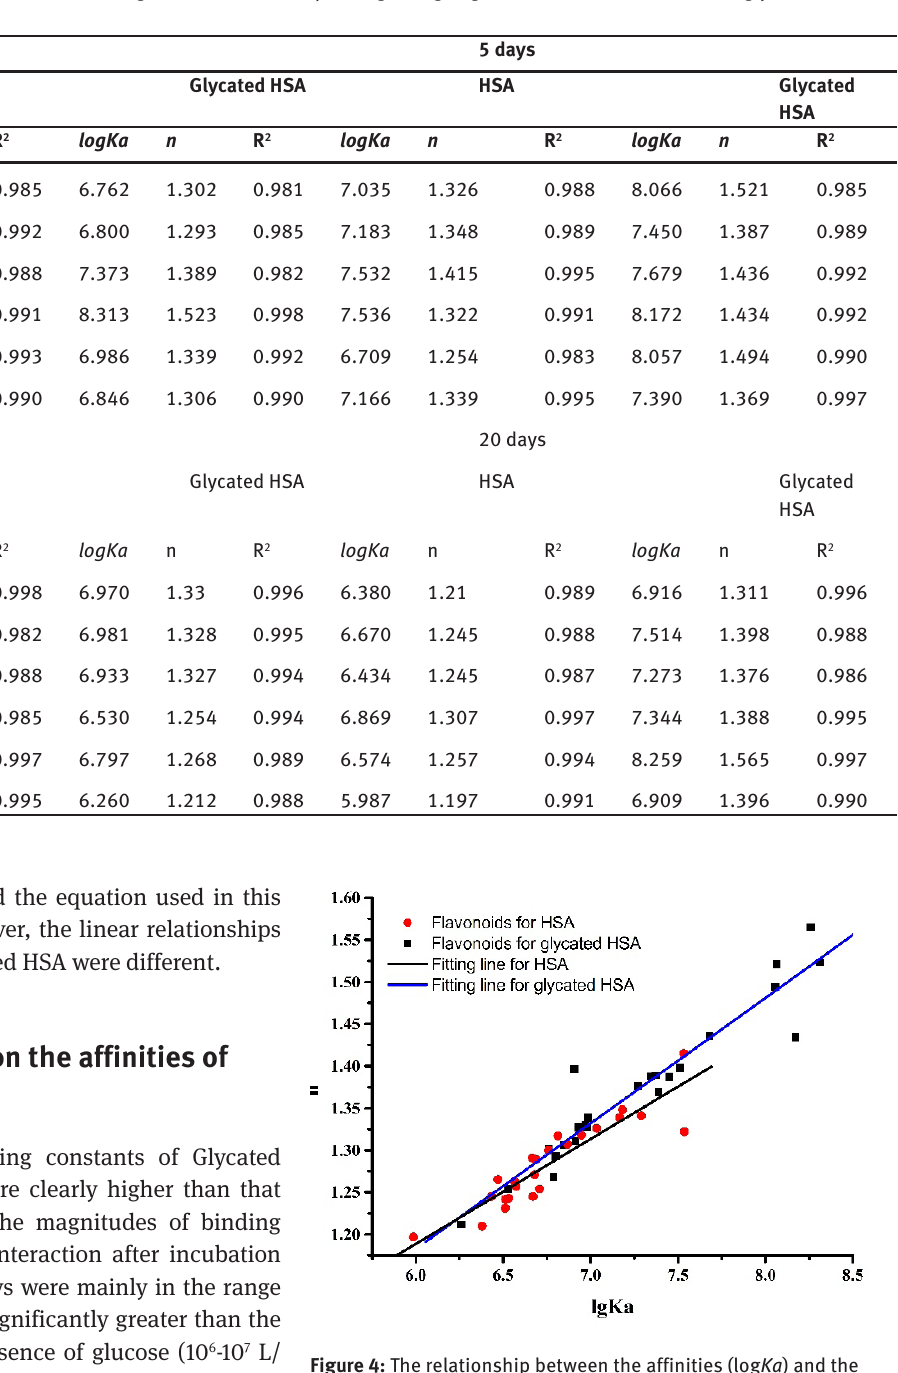
Figure 4: The relationship between the affinities (log Ka ) and the number of binding sites ( n ) for HSA and glycated